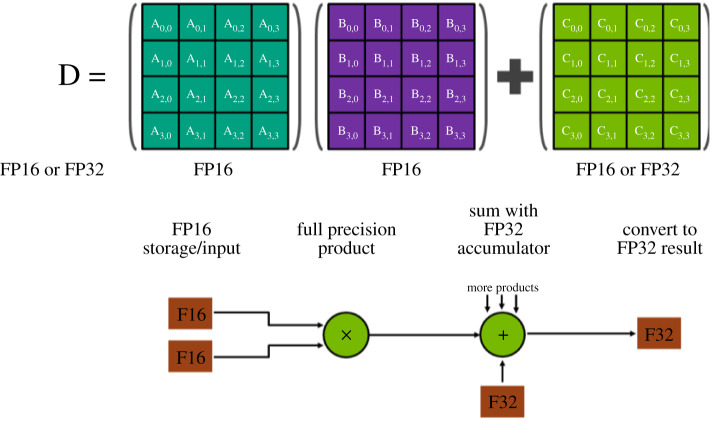
Tensor Core matrix multiply and accumulate, showing how products of scalars within a 4 × 4 matrix multiplication are formed and accumulated. (Online version in colour.)